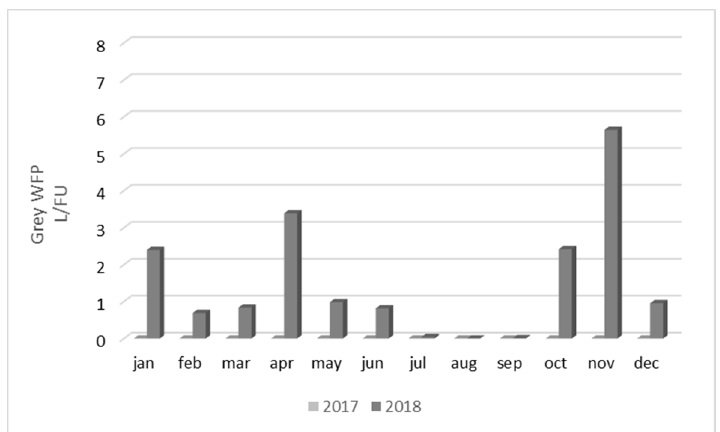
Figure 8. Grey water footprint regarding case study I—Lezíria do Tejo region, for both monitoring years.